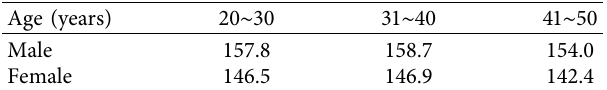
Table 1: Average basal metabolic rate of Chinese people [KJ/ (m 2 ∗